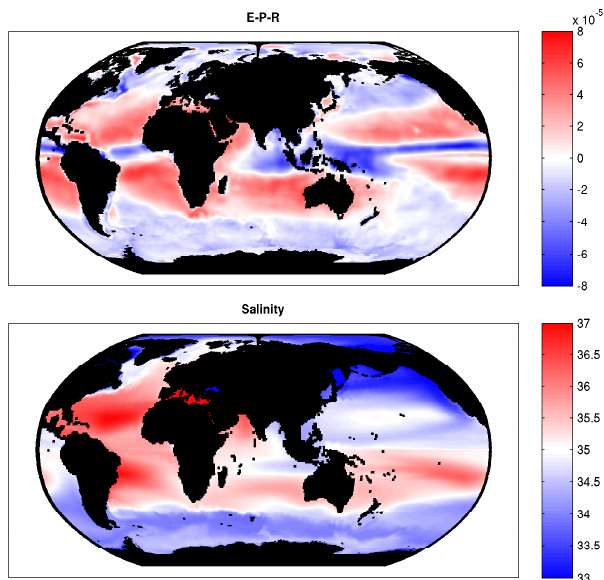
Fig. 1. Top panel: evaporation–precipitation–runoff flux for the global ORCA12 model (kgm − 2 s − 1 ). Positive values correspond to regions where evaporation is dominant. Bottom panel: salinity (PSU) averaged over the top 200m in the ORCA12 model. It is a time–mean over the last 10 years of an 85 year-long